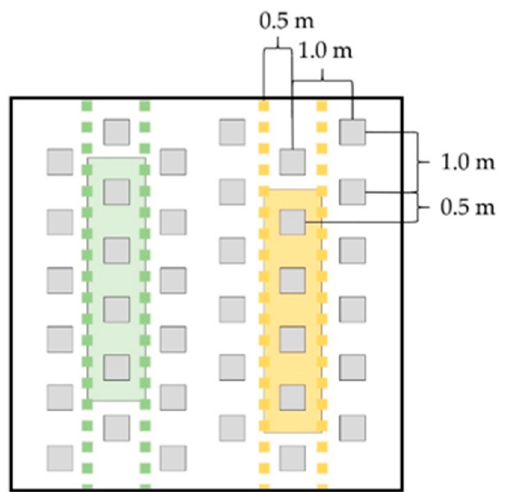
Figure 3. Schematic overview of the demonstration plot. The grey boxes represent miscanthus plantlets. The dotted lines represent undersown biennial species yellow melilot (green) and woad (yellow). The highlighted areas show sampling areas for yellow melilot (green) and woad (yellow).